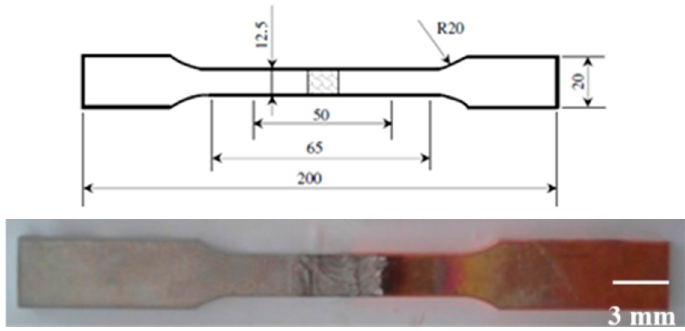
Figure 5. Dimension and macro imagine of the tensile specimen.